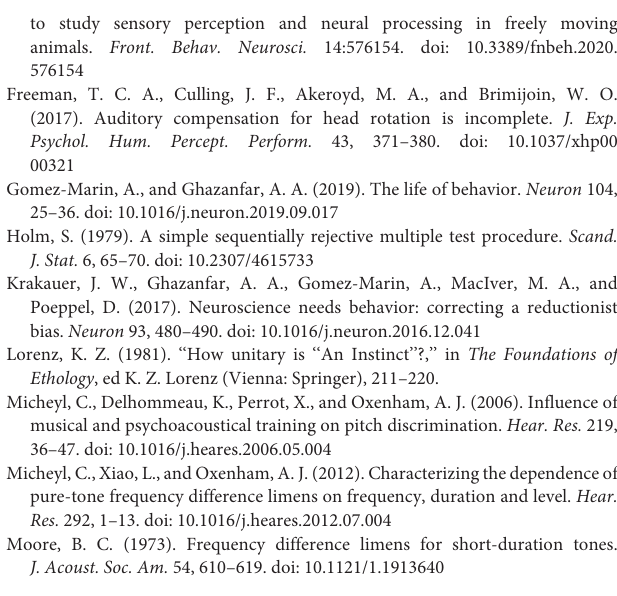
Supplementary Figure 2 | (A) Location of all the islands by task. (B) Location of the islands in the gradient task by the strategy used in the corresponding trial. Supplementary Figure 3 | The first 2 s of the subjects’ path for every gradient trial, separated by strategy. The black line depicts the border closest to the starting point. Note that strategy-specific trajectories can be observed even before having sensory feedback (i.e., before crossing the black line).